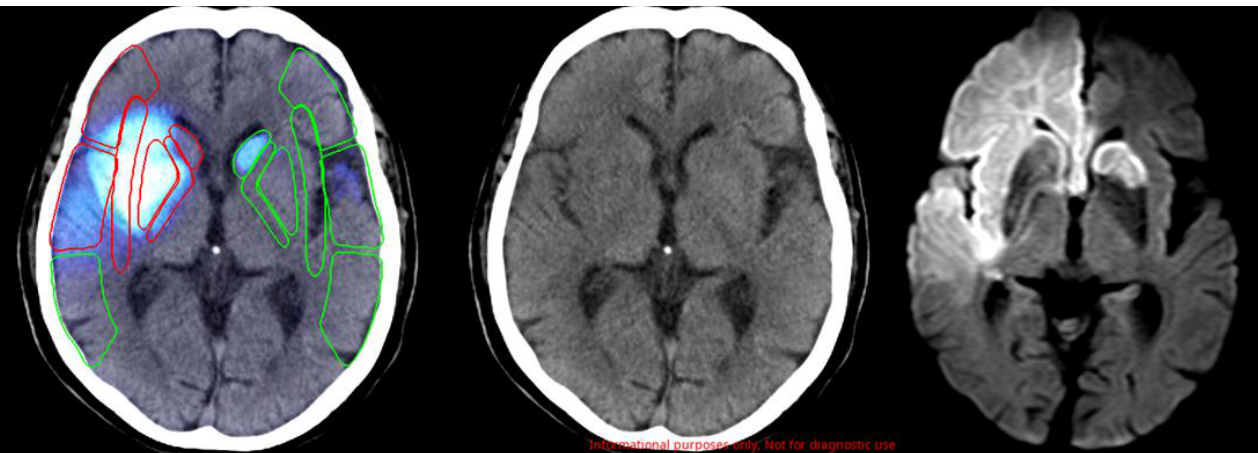
Figure 1. Representative images of ischemic stroke by AI software. From left to right: images assessed using the AI software, non-contrast head CT scan, and diffusion-weighted head MRI. In the AI software image, the red framed areas indicate early ischemic changes and the green framed areas indicate non-ischemic changes.